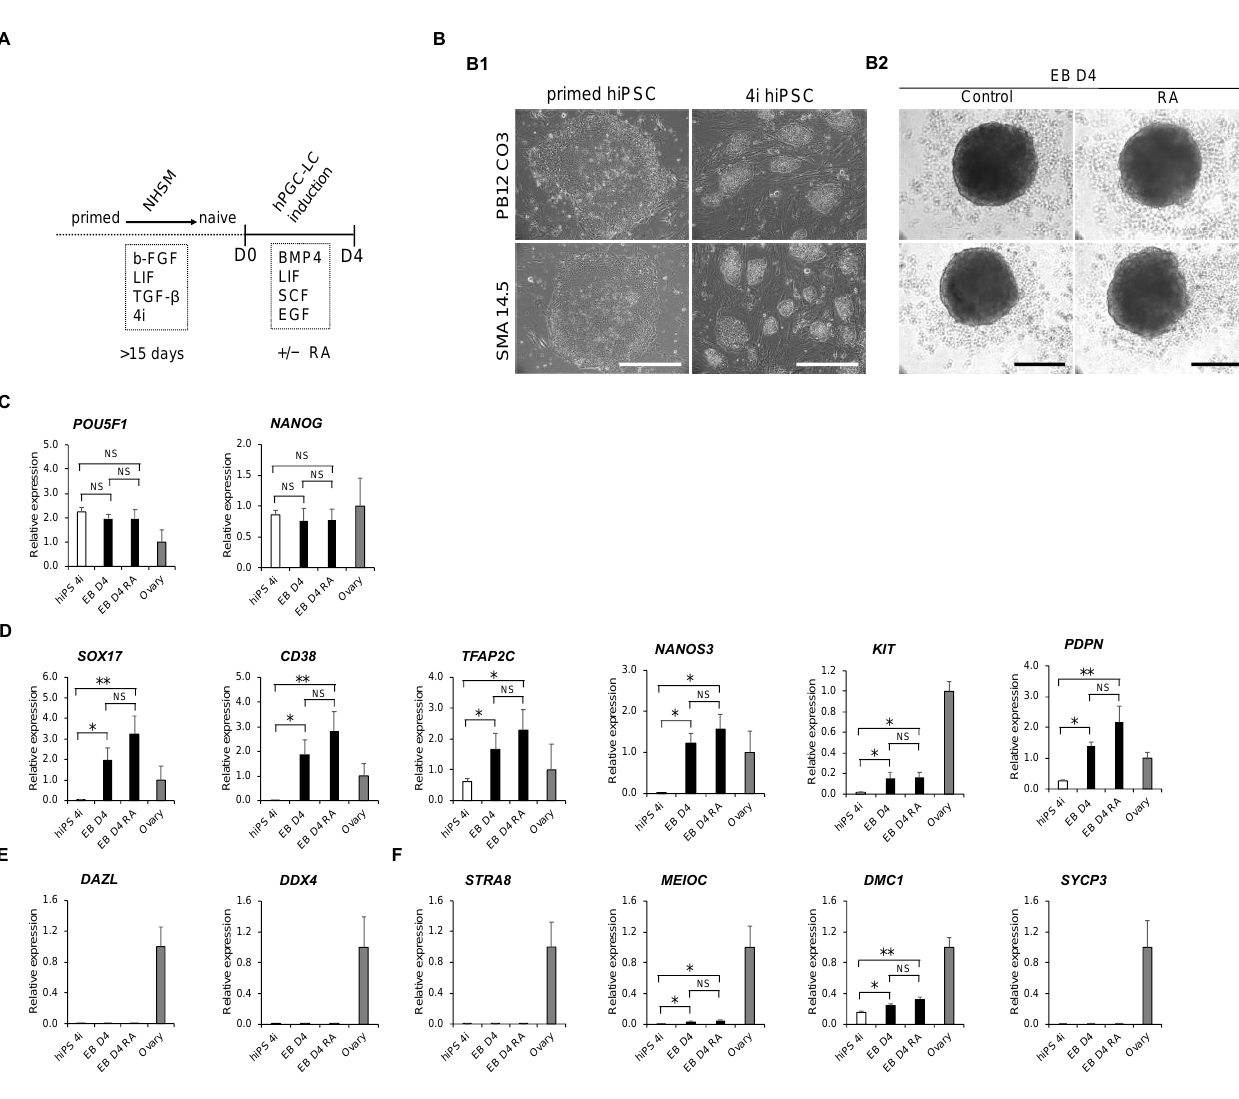
Figure 1. In vitro induction of early, but not late, hPGC-LC from hiPS cells. ( A ) Schematic illustration of in vitro specification procedure of hPGC-LC from hiPSCs. ( B ) In vitro day 4 embryoid body formation from naïve hiPSCs in the absence or presence of RA. ( B1 ): hiPS colony images in primed (large flat-shaped colony) and naïve (small domed-shaped colonies) states of pluripotency. ( B2 ): embryoid body images with or without RA. Scale bars, 500 µ m or 200 µ m, respectively. ( C–F ) Gene expression analysis of day 4 embryoid bodies by RT-qPCR with or without RA. The expression of pluripotency ( C ), early hPGC ( D ), late hPGC ( E ) and meiotic ( F ) gene markers are illustrated. The results are presented as the mean ± sem., with n = 4 (4i hiPS); n = 5 (EB D4); n = 6 (EB D4 RA) and n = 3 (7.8 to 10 GW human fetal ovary). Asterisk indicates a statistically significant difference (*: p < 0.05; **: p < 0.01). 4i: Four Inhibitory Molecules for naïve-like state of pluripotency; EB D4: Embryoid Body at Day 4; EB D4 RA: Embryoid Body at Day 4 with Retinoic Acid; NHSM: Naïve Human Stem cell Medium; NS: Not statistically Significant; RA: Retinoic Acid.